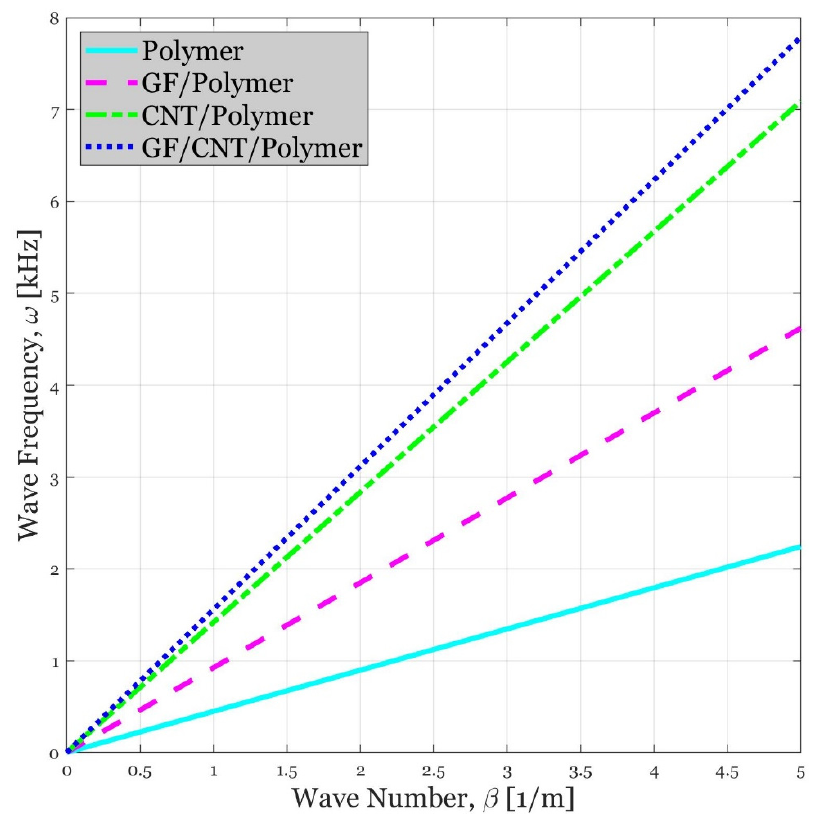
Figure 3. Comparison of acoustic wave frequency responses of sandwich plates fabricated from polymer, GF/polymer, CNT/polymer, and GF/CNT/polymer. α = 100 is employed in the cases which CNTs exist in the composition of the material. In this figure, the [ 0,30,45,60,90 ] used for the laminated composite.